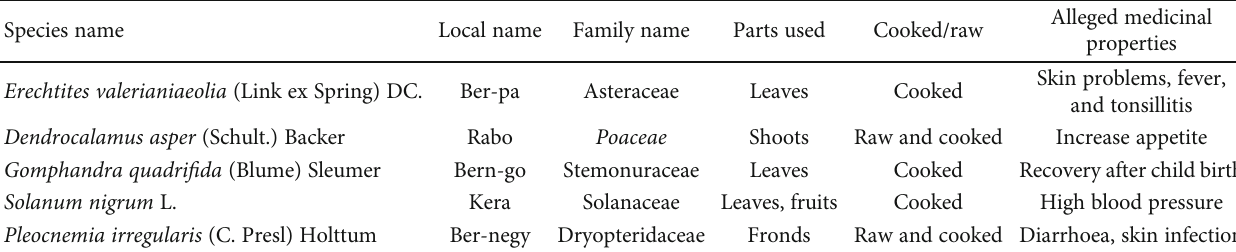
Table 1: Ethnobotany of wild edible plants selected for nutritional analysis.